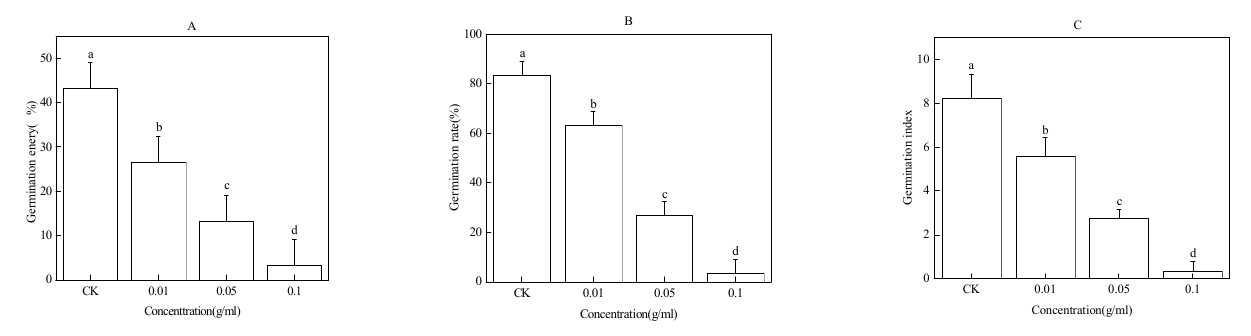
Figure 3. Effect of water extract of faba bean leaves on GE ( A ), GR ( B ), and GI ( C ) of faba bean seeds. Data are presented as the mean ± standard error of three biological replicates. Various letters for each index indicate significant differences at p < 0.05.